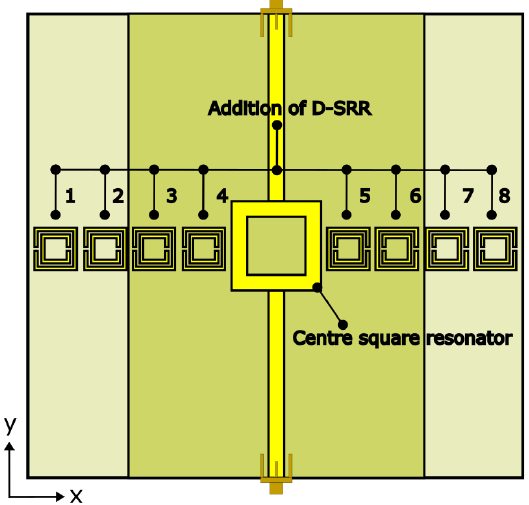
Figure 10. Addition of D-SRRs perpendicularly to the center resonator.